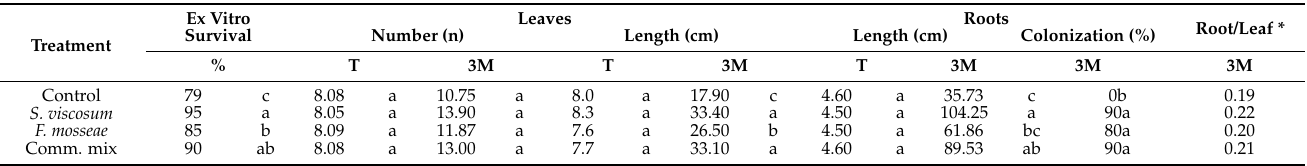
Table 2. Biometric parameters of ’Troianella‘ landrace plantlets inoculated with different AM fungi ( S. viscosum , F. mosseae , and commercial mix) or not inoculated (Control) at transplanting (T) and after 3 months (3M) of inoculation. Treatment